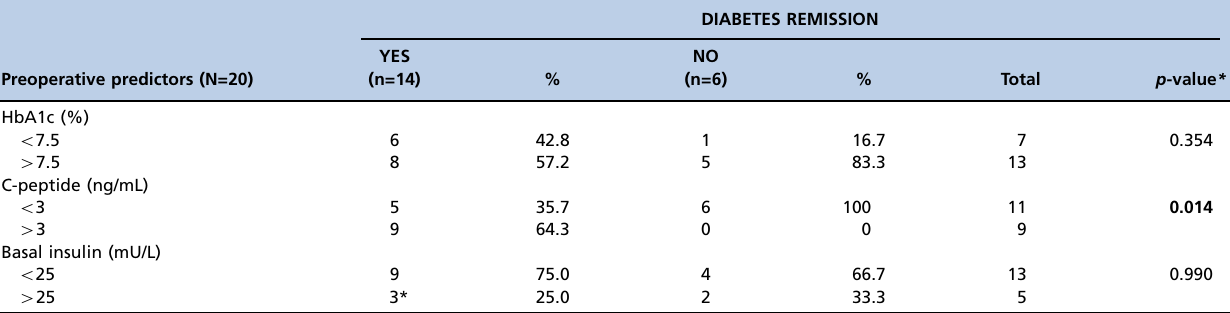
Table 2 - Preoperative predictors of diabetes remission at 3 years after Roux-en-Y gastric bypass in patients with severe obesity and type 2 diabetes mellitus (prospective phase). Diabetes remission was defined as a fasting glycemia level o 126 md/dL and/or glycated hemoglobin (HbA1c) level o